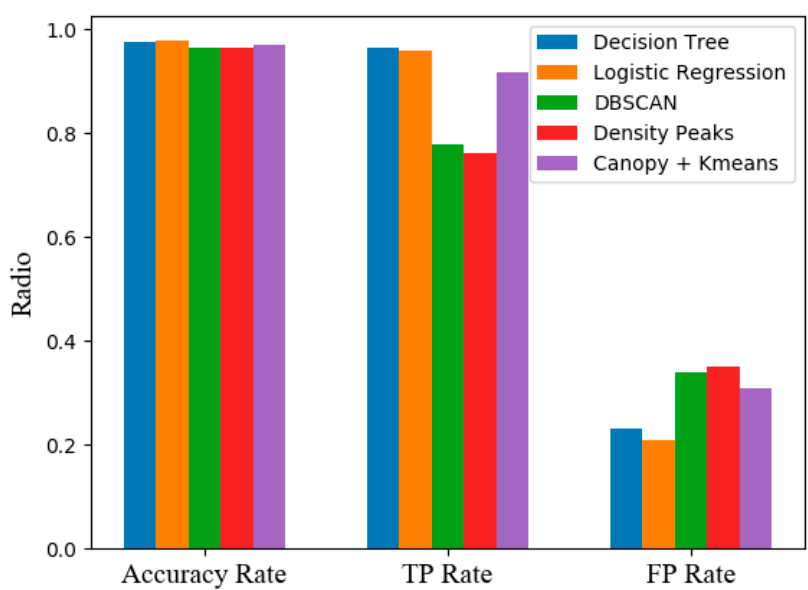
Figure 8. Experimental comparison (FP Rate is multiplied by ten for easier comparison).